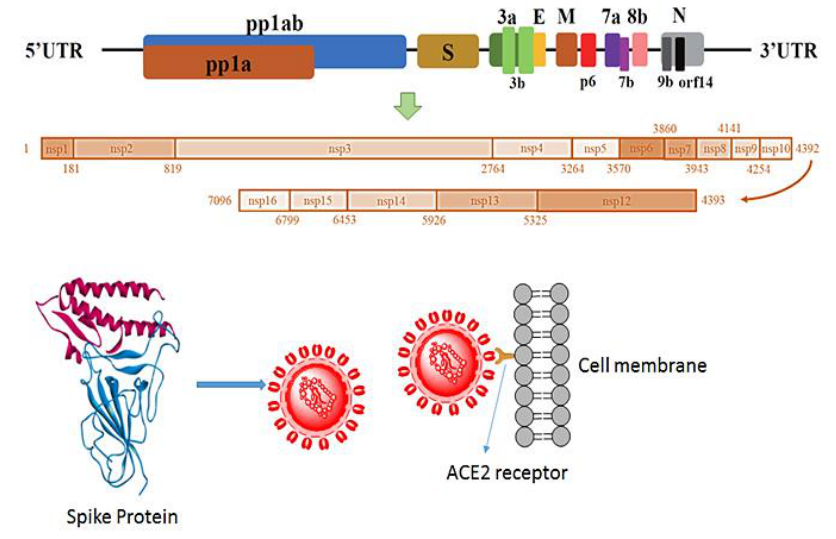
Figure 1. Spike protein development of coronavirus and its binding with